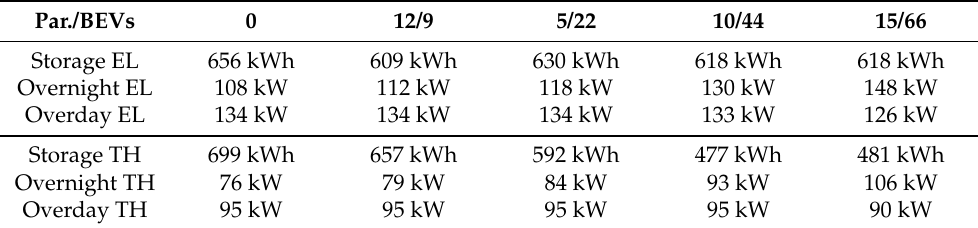
Table 6. Power demand including Electromobility, including Storage